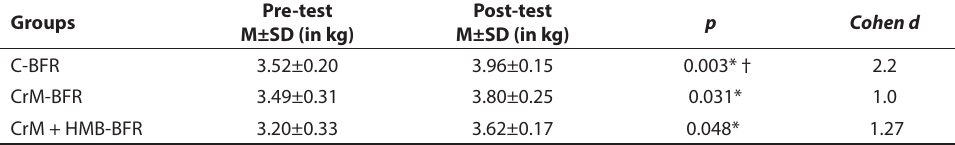
TABLE 2 Outcomes for the Biceps Muscle Thickness Before (pre-test) And After (post-test) Intervention Pre-test Groups M±SD (in